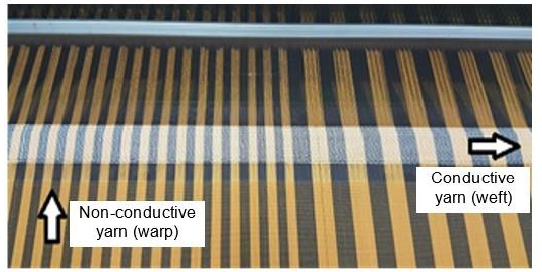
Figure 2. Warp and weft of the manufactured electro-textile fabric. The conducting part was made from a mixture of copper and polyester threads, with the weight ratio of 83% and 17% for copper and polyester, respectively.